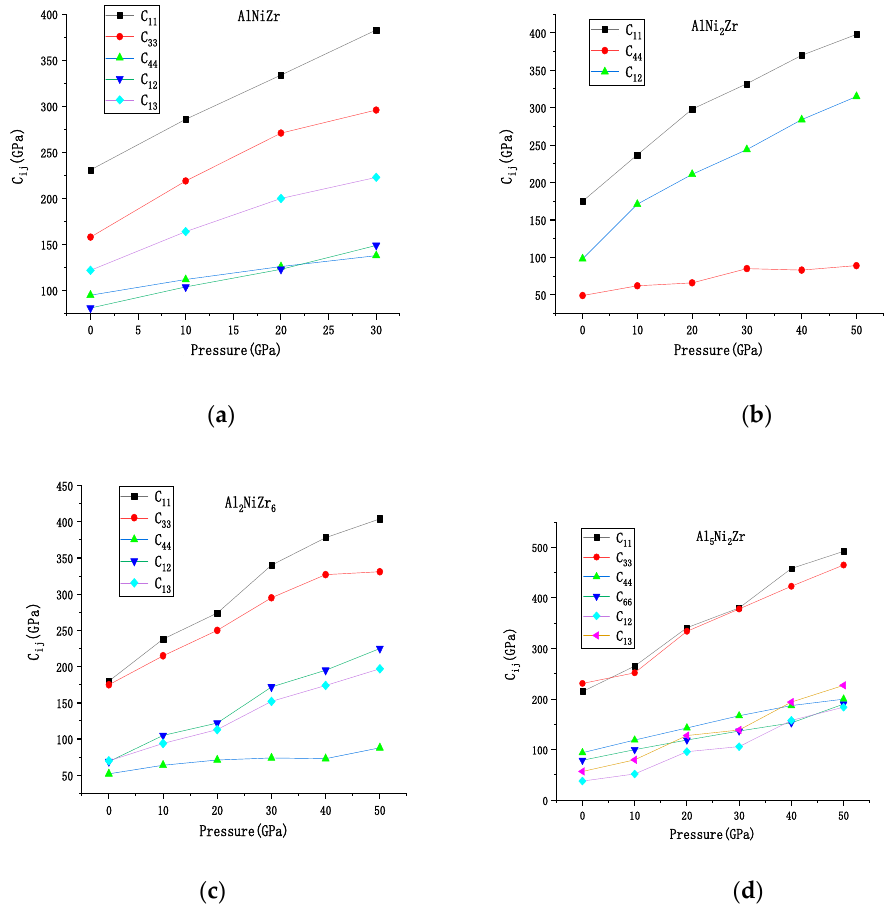
Figure 2. Calculated pressure dependence of the elastic constants C ij for Al x Ni y Zr z compounds: ( a ) AlNiZr, ( b ) AlNi 2 Zr, ( c ) Al 2 NiZr 6 , ( d ) Al 5 Ni 2 Zr.